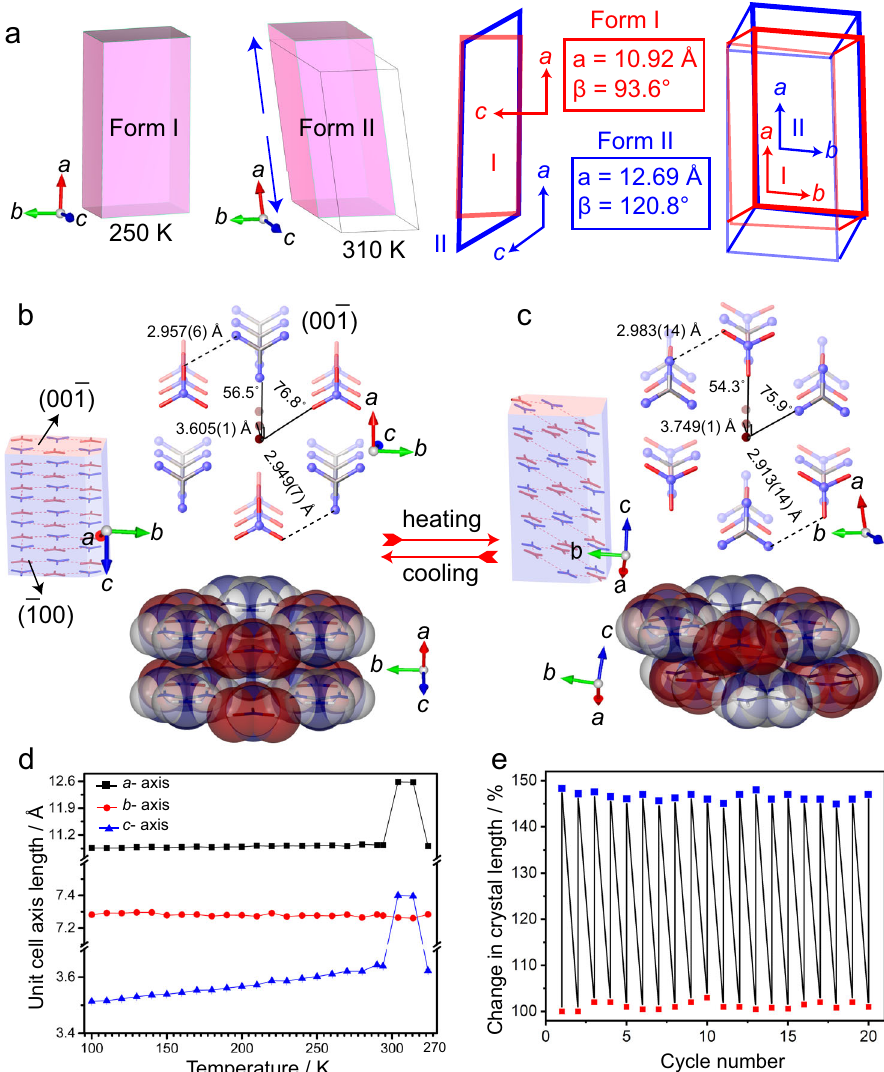
Fig. 2 Changes in the crystal structure and crystal size and shape during the phase transition. a Comparison of the unit cells before and after the phase transition. The values of the characteristic unit cell parameters in the two phases are given. The doubling of the c axis that occurs during the transition from form I to II is not shown here. b , c Cartooned crystal habits of form I ( b ; 250 K) and form II ( c ; 310 K) shown with molecular orientation in form I ( b ) and form II ( c ) crystals viewed in the [001] and [100] directions. Upon heating from 290 to 310 K, the distance between the adjacent sheets containing nitrate and guanidinum ions increases from 3.605 to 3.749 Å while the adjacent hexameric layers are apparently twisted in respect to each other. d Changes in the unit cell parameters of form I before and during the reversible phase transition. e Cyclability of a good-quality single crystal over the phase transition monitored by the change in its length. The expansion and shrinkage of the crystal were recorded over 20 thermal